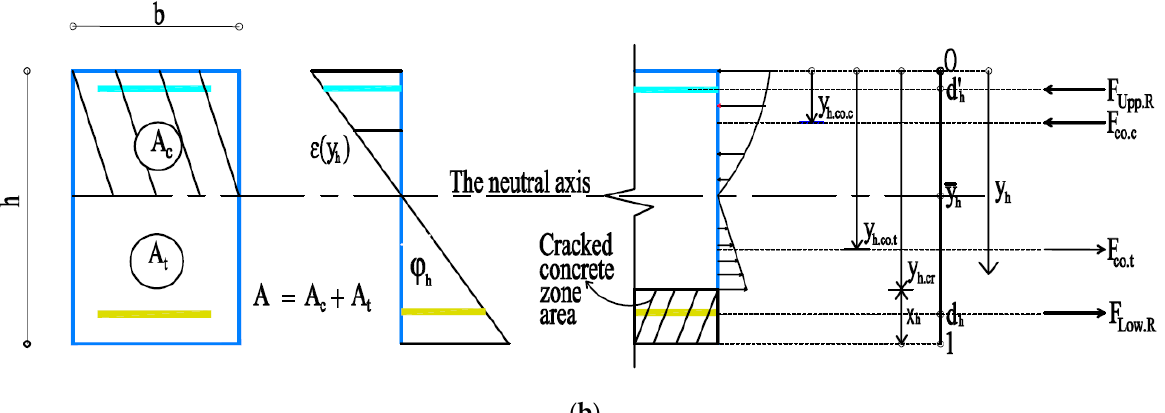
Figure 7. Stress and strain distribution of the cross-section under the balanced condition: ( a ) un-cracked state of tensile concrete; ( b ) cracked state of tensile concrete.